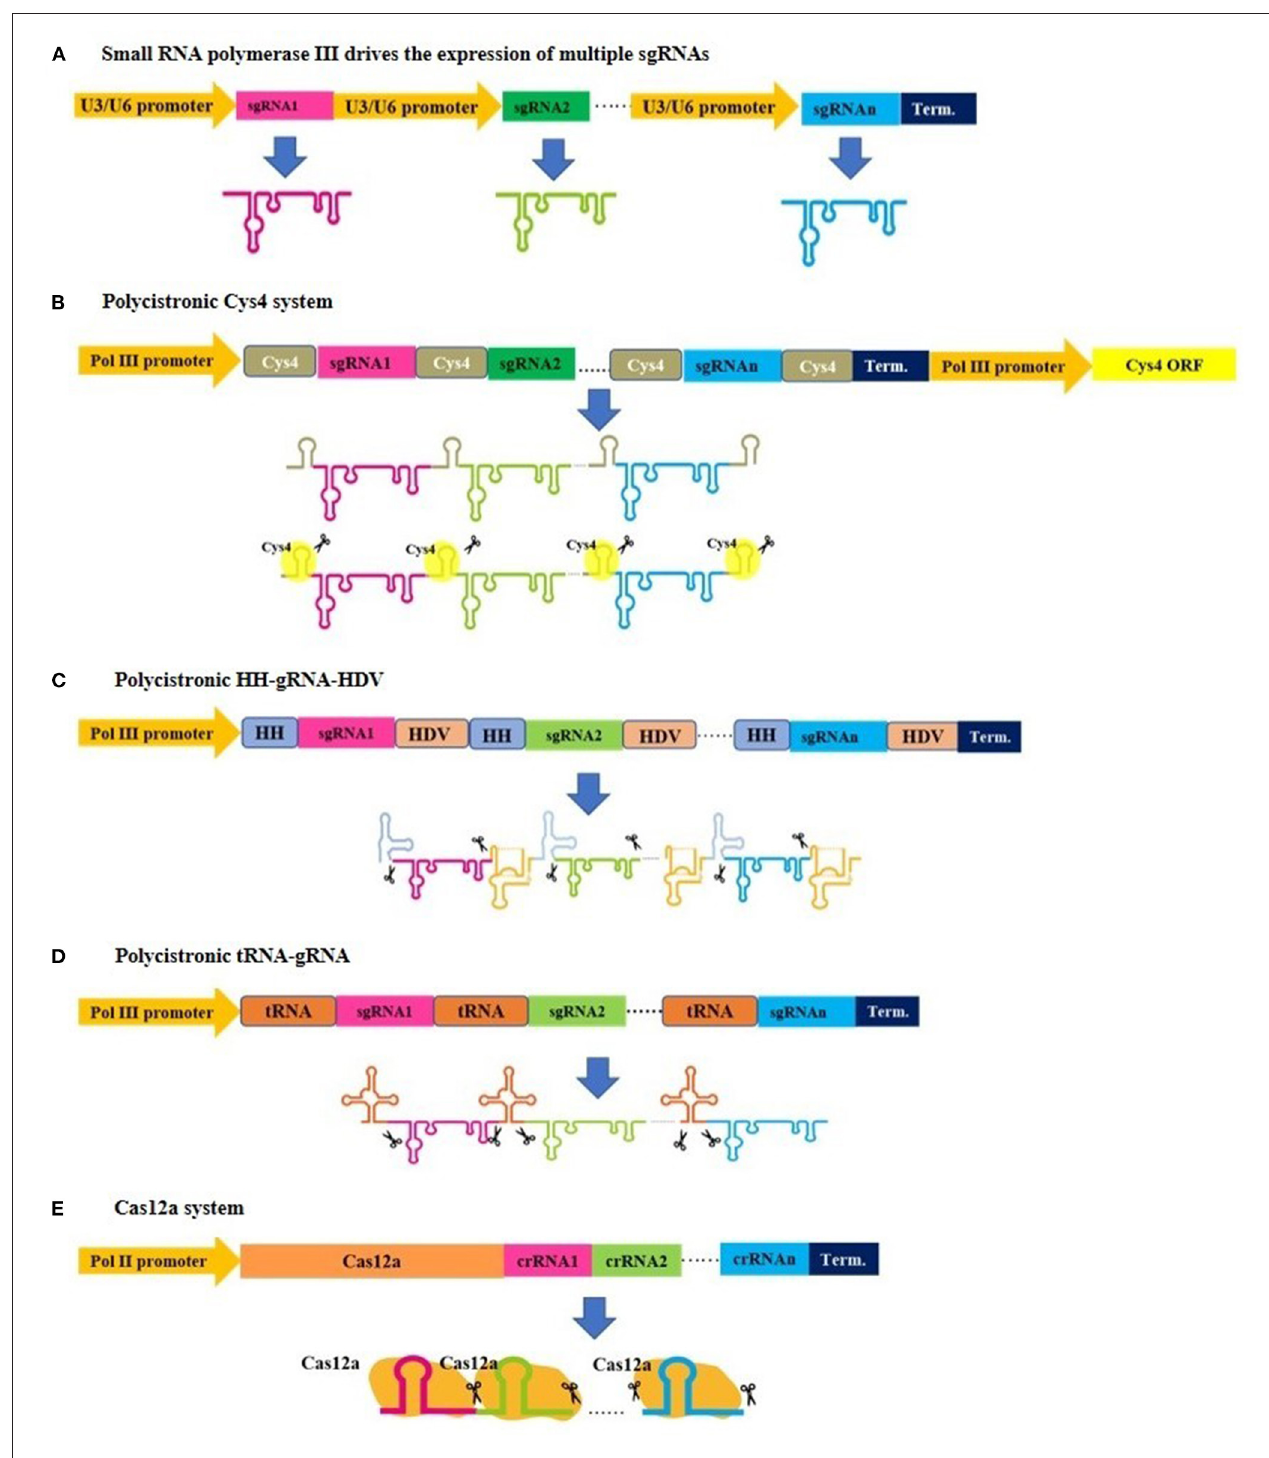
FIGURE 1 | An illustration demonstrating various strategies for expressing multiplex gRNA cassettes in plants. (A) Small gRNAs are cloned after U3 or U6 promoters and derived by small RNA polymerase III to generate individual gRNAs. (B–D) Small gRNAs are cloned to be transcribed into a single transcript, and subsequent posttranscriptional processing is needed for gRNA separation, where Csy4, tRNAs, and hammerhead ribozyme regulate this separation. Similarly, a single transcript is generated in the (E) Cas12a system, but this system has a gRNA self-cleaving feature and does not require additional elements for posttranscriptional processing.